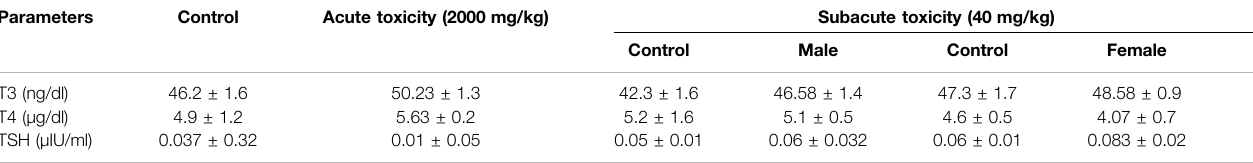
The data is represented as mean ± SEM with n (cid:1) 5 for acute and n (cid:1) 10 for subacute toxicity